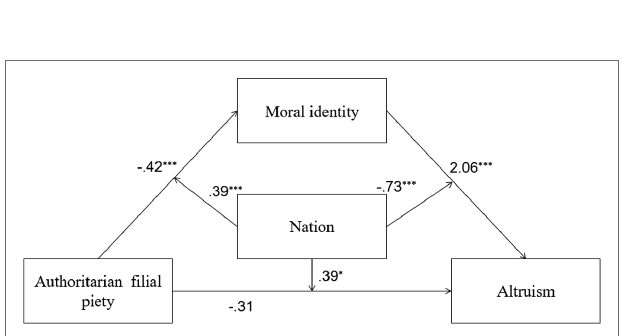
FIGURE 6 | Moderated mediation model showing standardized coefficients (Model 6); * p < 0.05; *** p < 0.001.